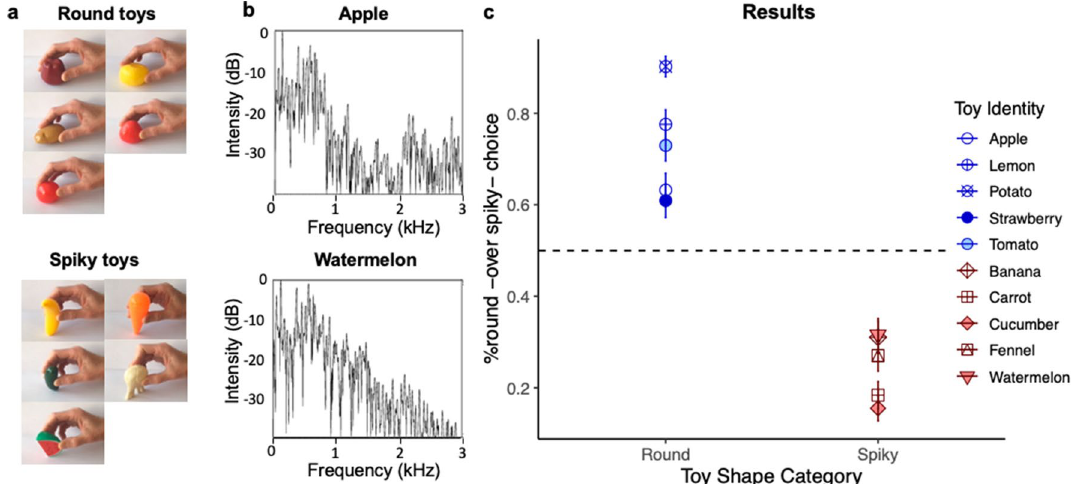
Figure 4. Stimuli and results from the Beating Toys Experiment. ( a ) Images of the visual stimuli (children’s plastic toy reproductions of fruits and vegetables). ( b ) Typical frequency spectrum resulting from hitting the base of a round (apple) or the tip of a spiky (watermelon slice) object on a hard surface. The spectral balance is lower for the round as compared to the spiky object. ( c ). Percentage of round (over spiky) score averaged across participants as a function of each stimulus object and Toy Shape Category (from left to right, Round: Apple, Lemon, Potato, Strawberry, Tomato; Spiky: Banana (tip), Carrot (tip), Cucumber (tip), Fennel (tip), Watermelon slice (tip)). Error bars are standard error from the